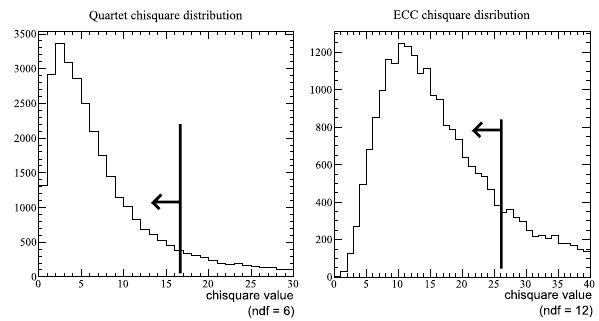
Fig. 6. Resultant distributions of χ 2 values for the quartet detector (left: ndf = 6; ndf – number of degrees of freedom) and ECC de- tector (right: ndf = 12). The solid vertical line represents the upper bound we used based on the chi-square criterion ( p value >